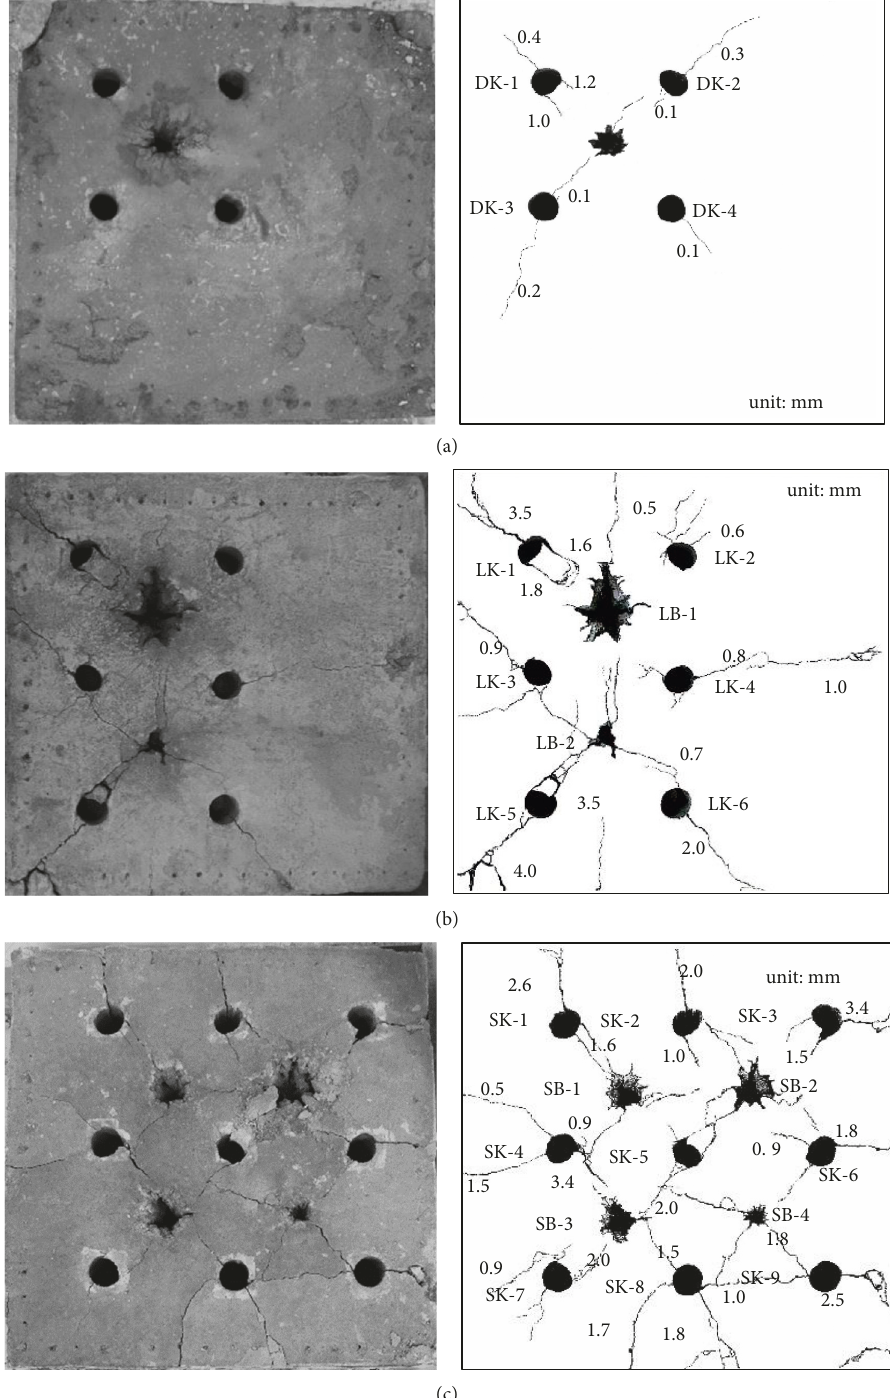
Figure 10: Crack morphology and resistivity distribution diagram after blasting. (a) Single-hole blasting model. (b) Double-hole blasting model. (c) Four-hole blasting